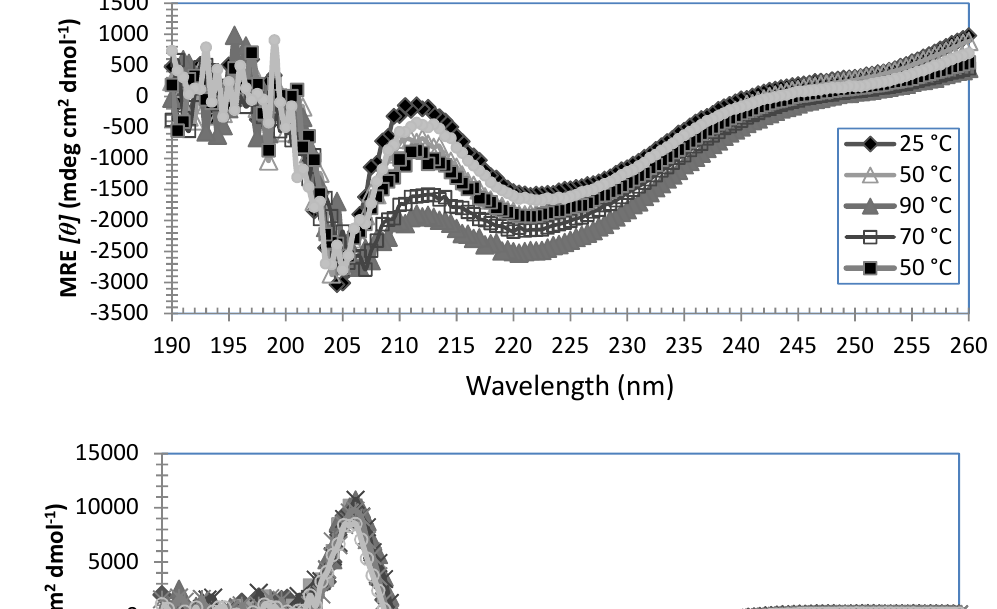
K in water. The strong 6 K in water. Strong negative MRE 6 K and 6